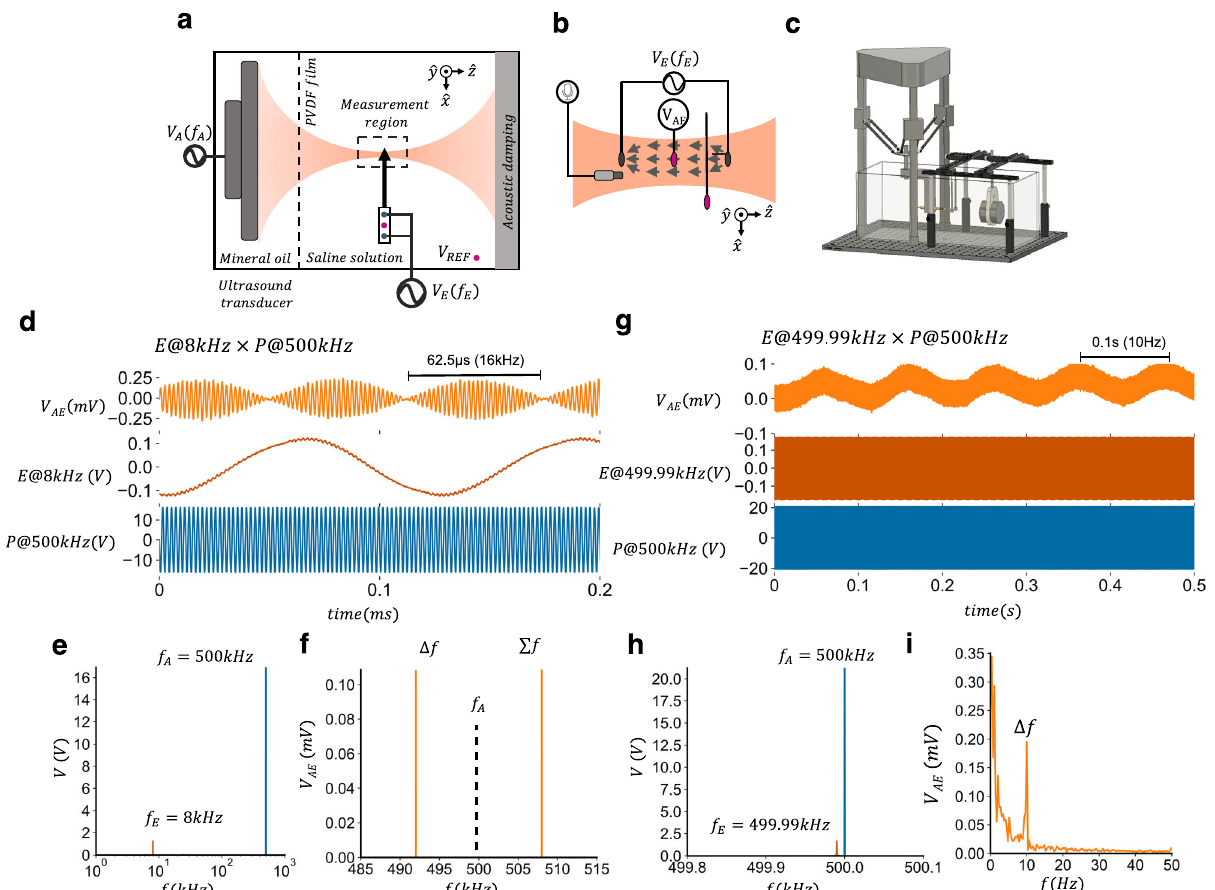
Fig. 3 Measurements of acoustoelectric frequency mixing in a tissue phantom. Time – frequency characteristics of the electric fi eld generated by ! ð x ; y ; z Þ to a saline fi lled tank. a Schematic of the experimental simultaneous application of a focal acoustic pressure fi eld P ( x,y,z ) and an electric fi eld E setup, showing setup overview, b zoomed view of the boxed measurement region in ( a ); V A applied electrical potential from RF power ampli fi er driving the ultrasound transducer at a frequency f A ; V E , applied electrical potential from arbitrary waveform generator and custom-made voltage source to the electrodes at a frequency f E ; V AE measured acoustoelectrically generated electric potential (see Supplementary Figs. 3, 4 for characterization of